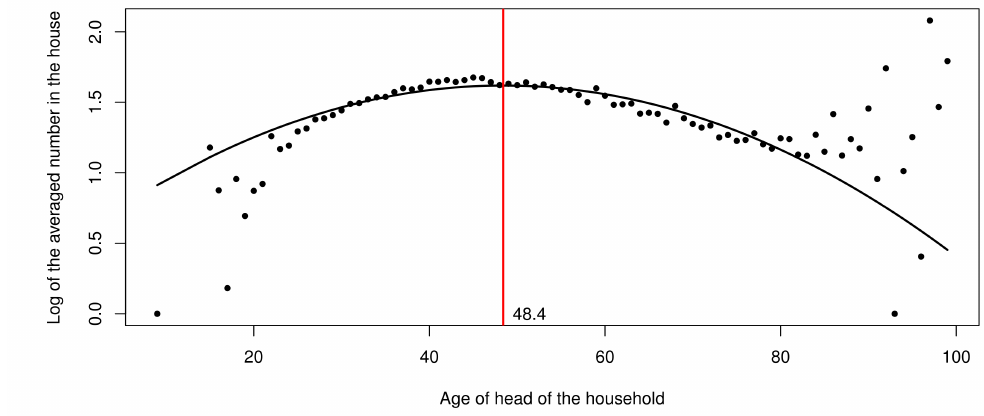
Figure 2. Plot of the log of the averaged counts for each age in years (dots) and fitted solid curve of the log of the true rate.